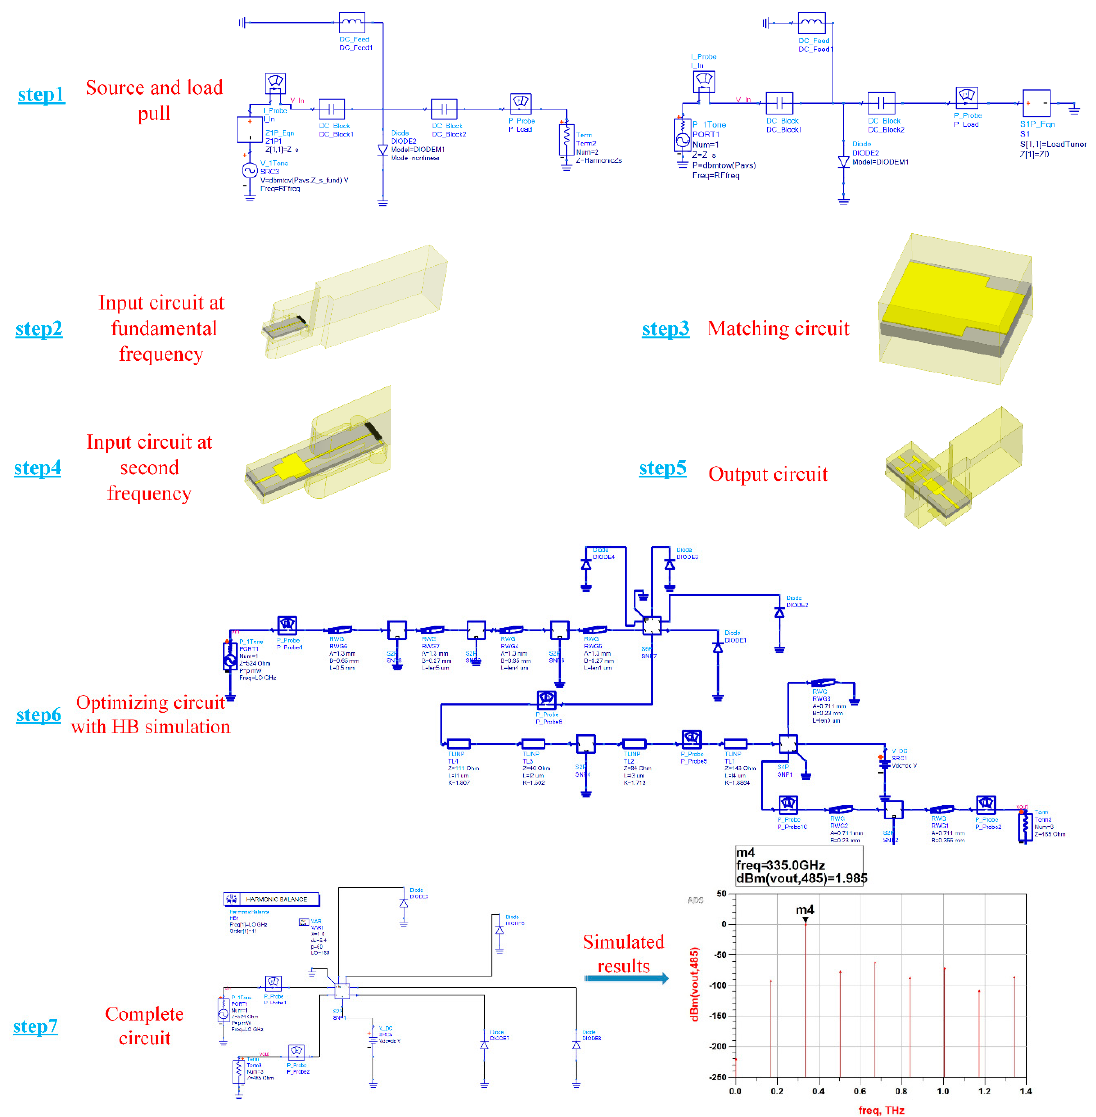
Figure 6. Design process of a 335 GHz balanced doubler with the field-circuit method.